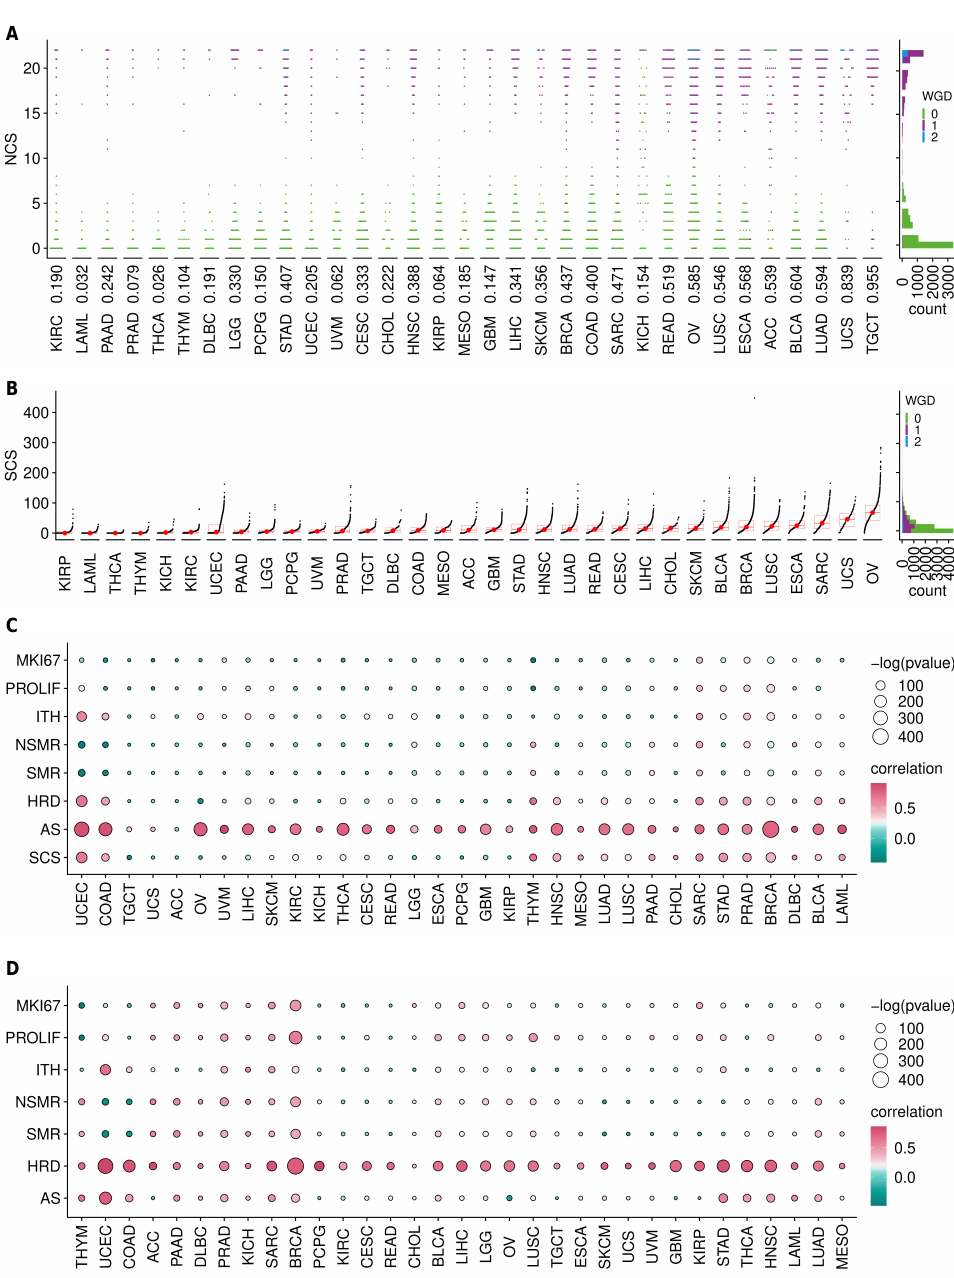
Figure 1. Distribution of CIN scores and their association with genetic instability. ( A ) Left: NCS for TCGA tumour samples (dots) from different cancer types, sorted according to median NCS. The colour coding indicates the WGD status and the number below each beeswarm plot is the proportion of samples which underwent WGD. Right: Pan-cancer histogram of NCS. ( B ) SCS for tumour samples from different cancer types, ordered by their median SCS. Right: Pan-cancer histogram of SCS with colours indicating WGD status. ( C , D ) Correlation between NCS ( C ) or SCS ( D ) with different indices for genetic instability, intra-tumour heterogeneity and proliferation: MKI67 expression, proliferation rates (PROLIF), intra-tumour heterogeneity (ITH), non-silent mutation rate (NSMR), silent mutation rate (SMR), homologous recombination deficiency (HRD) and aneuploidy score (AS). Data for these indices were collected from